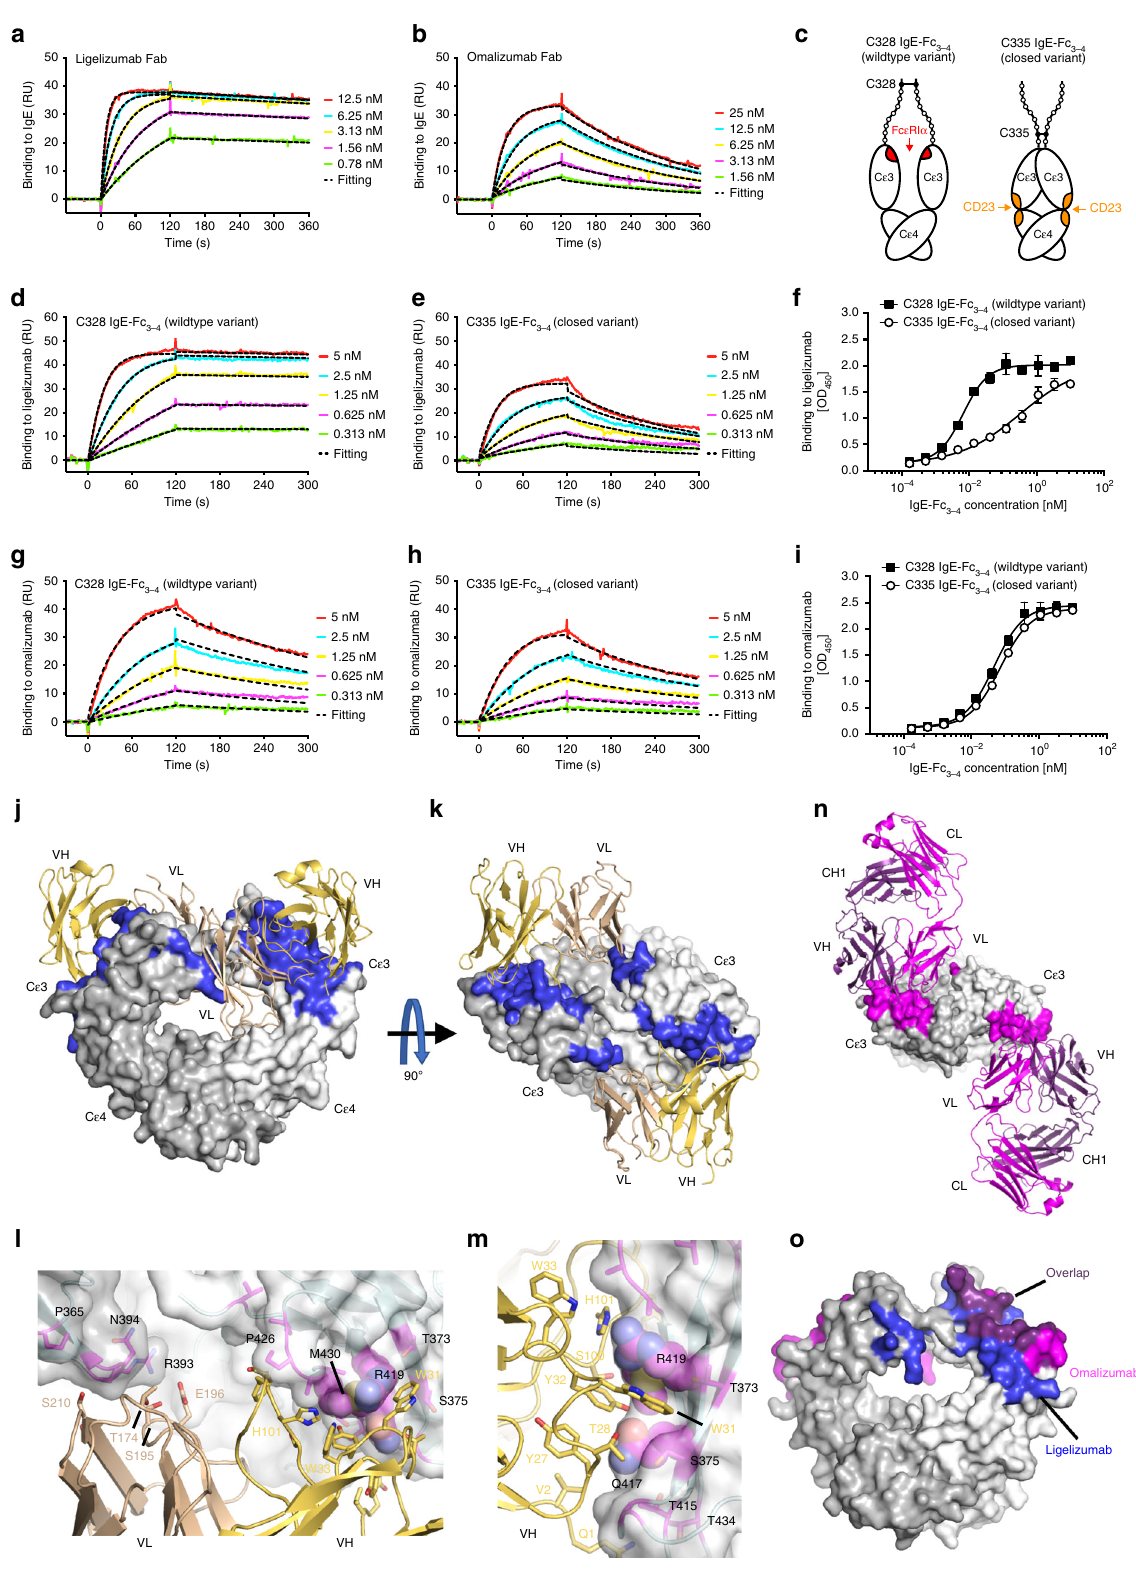
Ligelizumab and omalizumab clearly bind to different epitope structures on the IgE-Fc dimer; however, they share a signi fi cant overlapping region (Fig. 1n, o). In addition, the angle of binding of the two antibodies relative to the IgE-Fc domain also differs, affecting their respective functions in receptor inhibition.